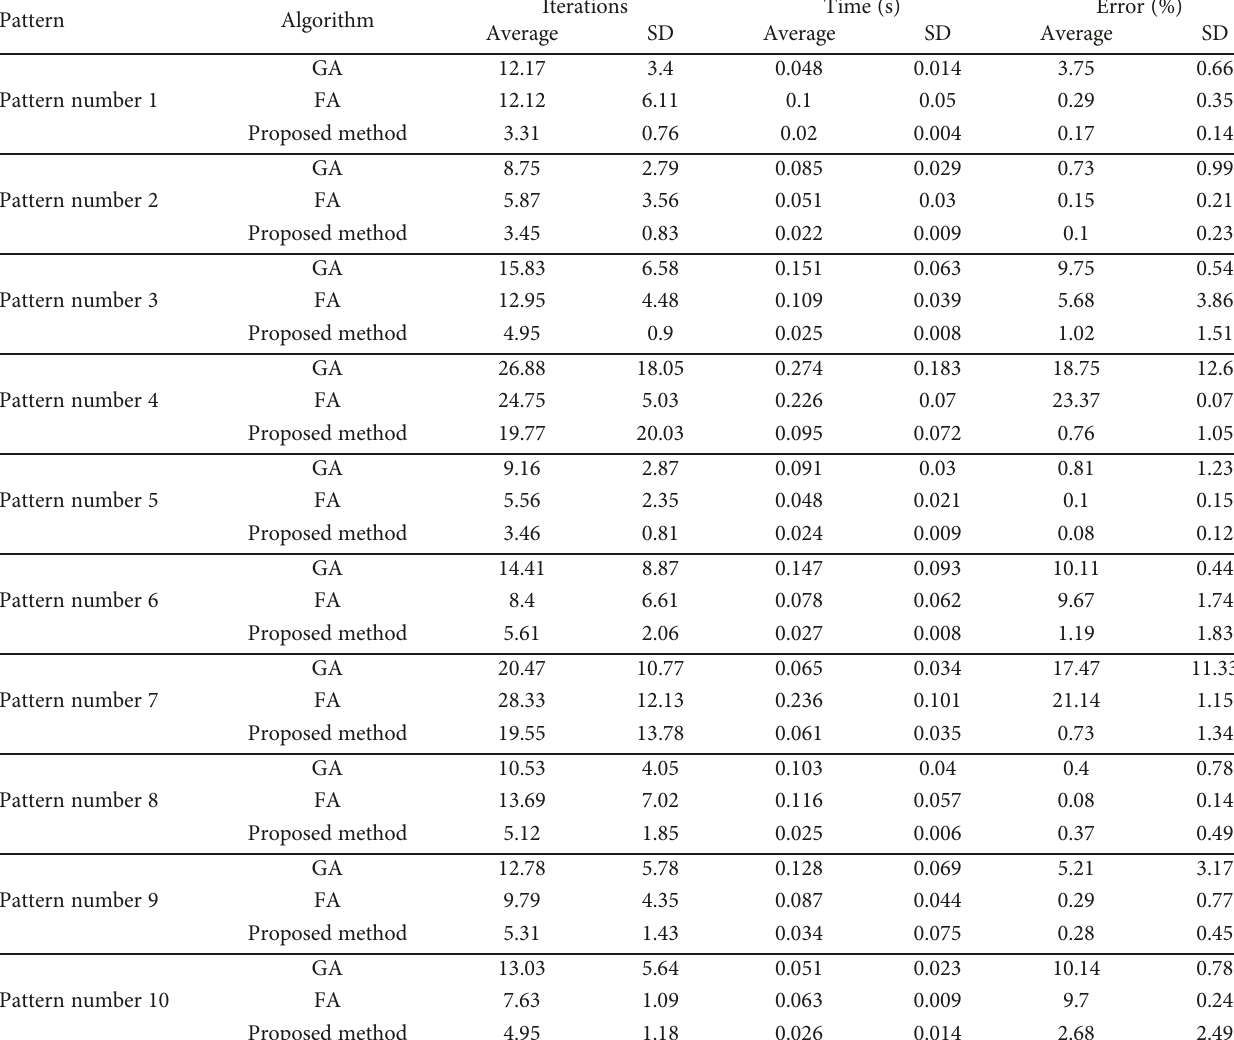
Table 8: Simulation results of the tracking speed and tracking accuracy.